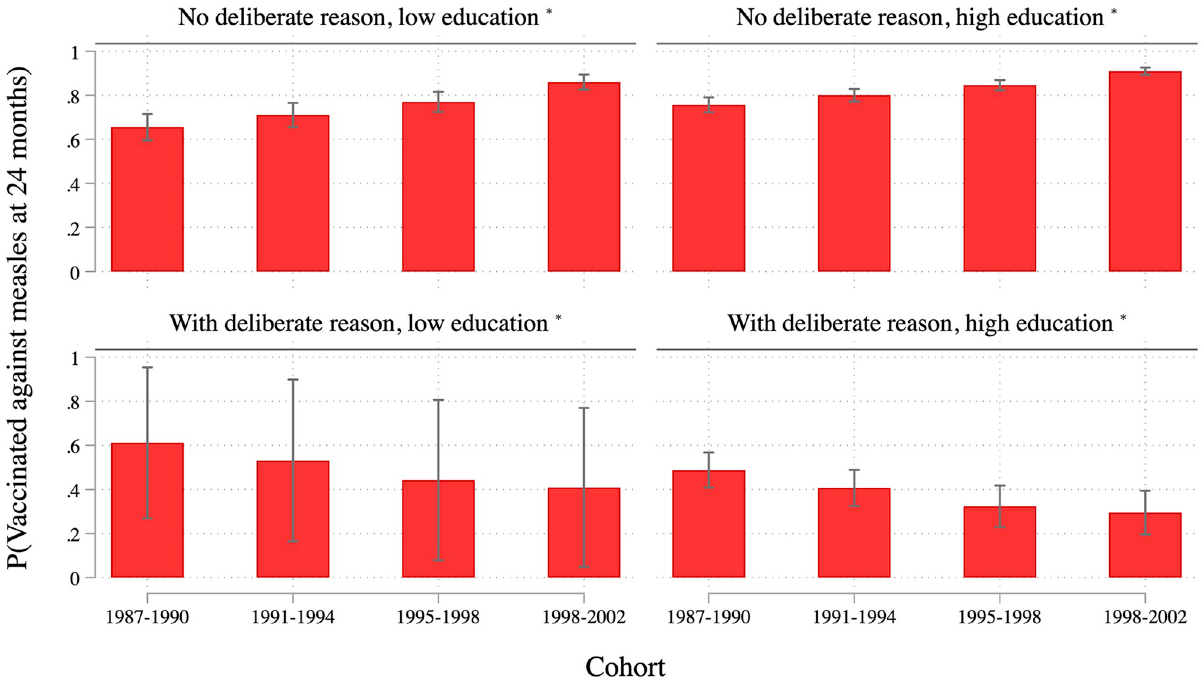
Fig 7. Predictive margins from logistic regression predicting vaccination behavior. Predictive margins and 95 percent confidence intervals based on logistic regression with multiply imputed and weighted data (see S4 Table). � non-migrant family with female child in large West-German town without older siblings, younger mother, going to nonparental supervision at age 3, and without non-deliberate reasons.